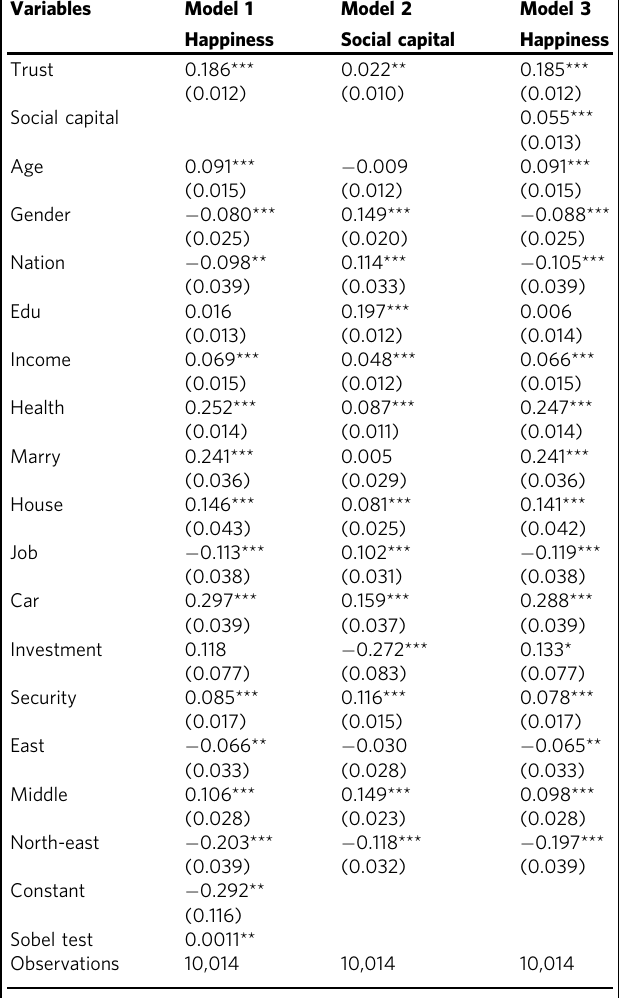
Table 3 Oprobit and OLS regression analyses on happiness by trust and social capital.